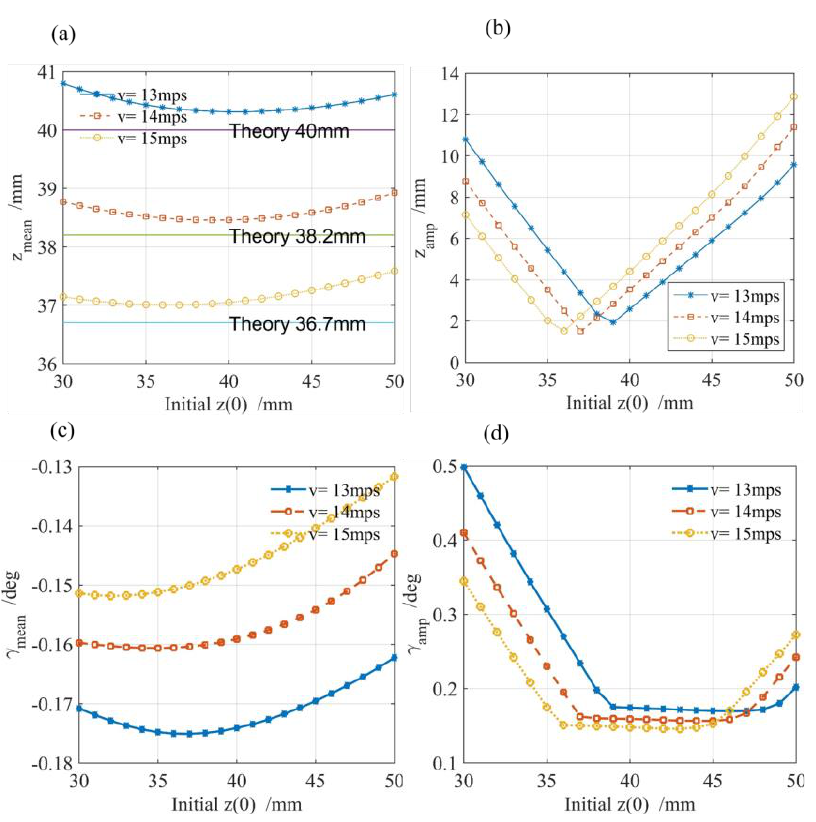
Figure 13. Simulation results when MMF = 310 kAt: ( a ) z mean ; ( b ) z amp ( c ) γ mean ; ( d ) γ amp .